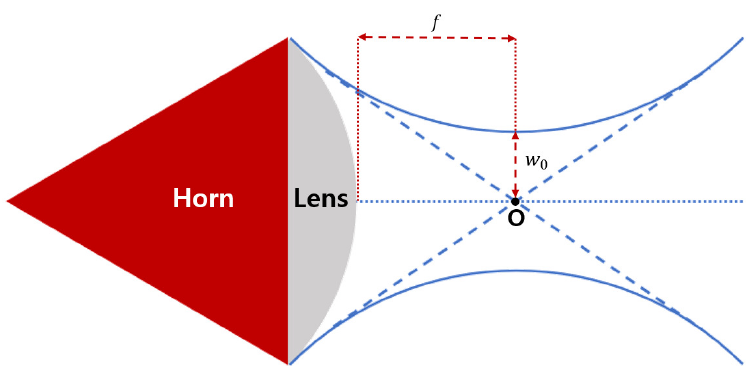
Figure 3. Diagram of the focused-beam lens horn